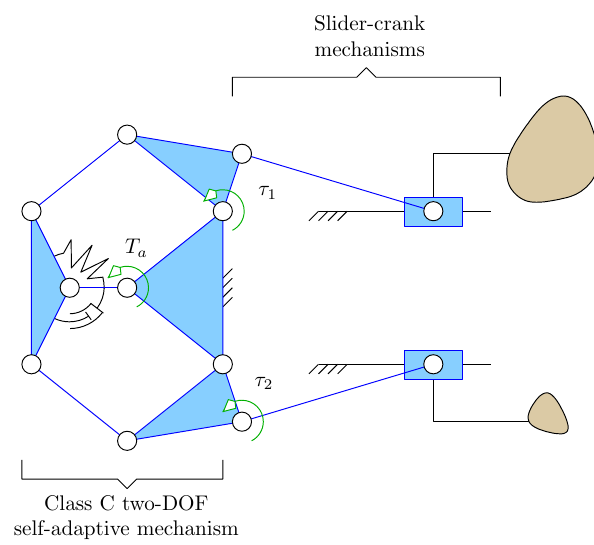
Figure 10. A two-DOF self-adaptive linkage driving two slider- crank